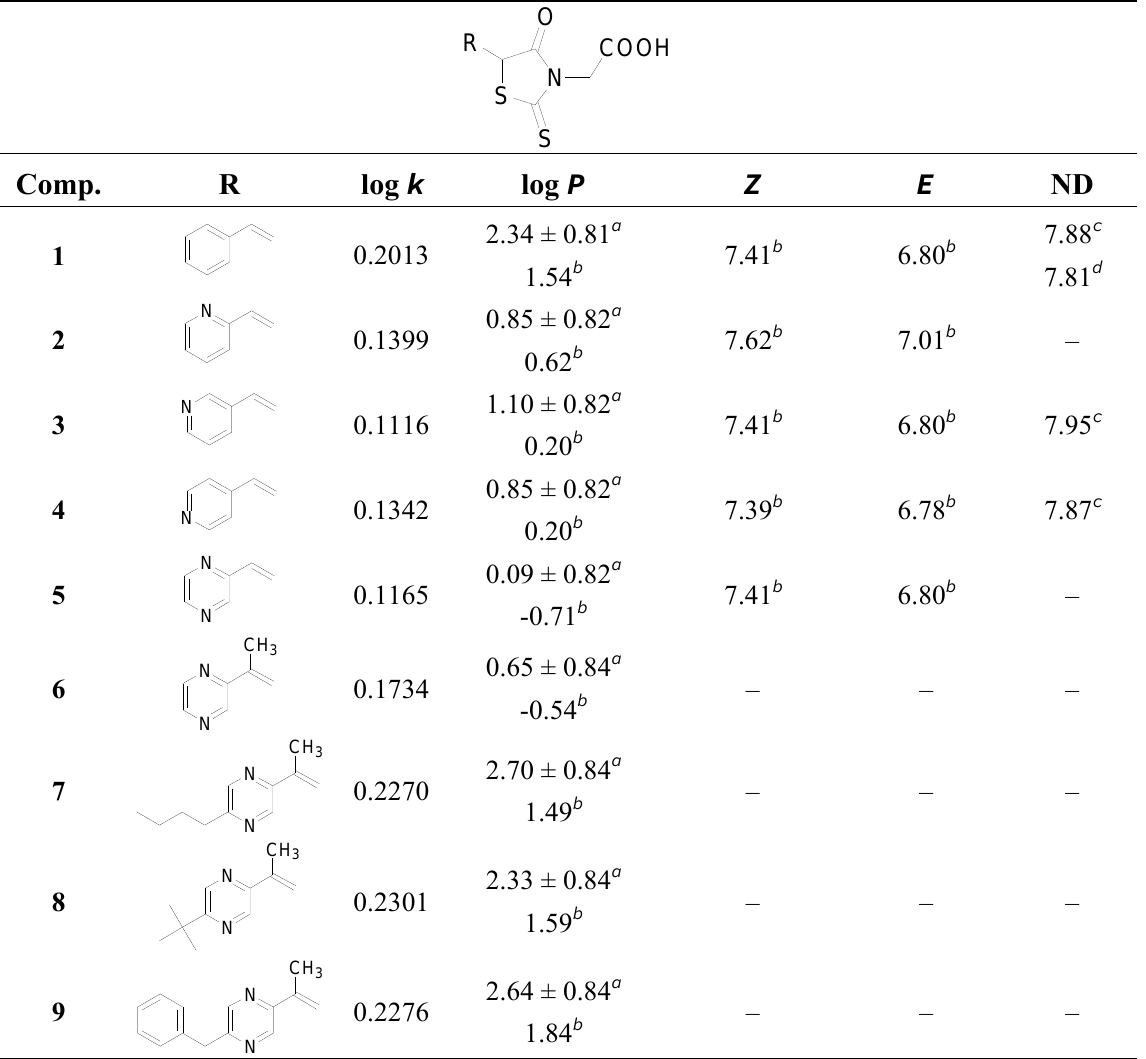
Table 1. Lipophilicities and 1 H-NMR shifts for the methine hydrogen ( δ , ppm)